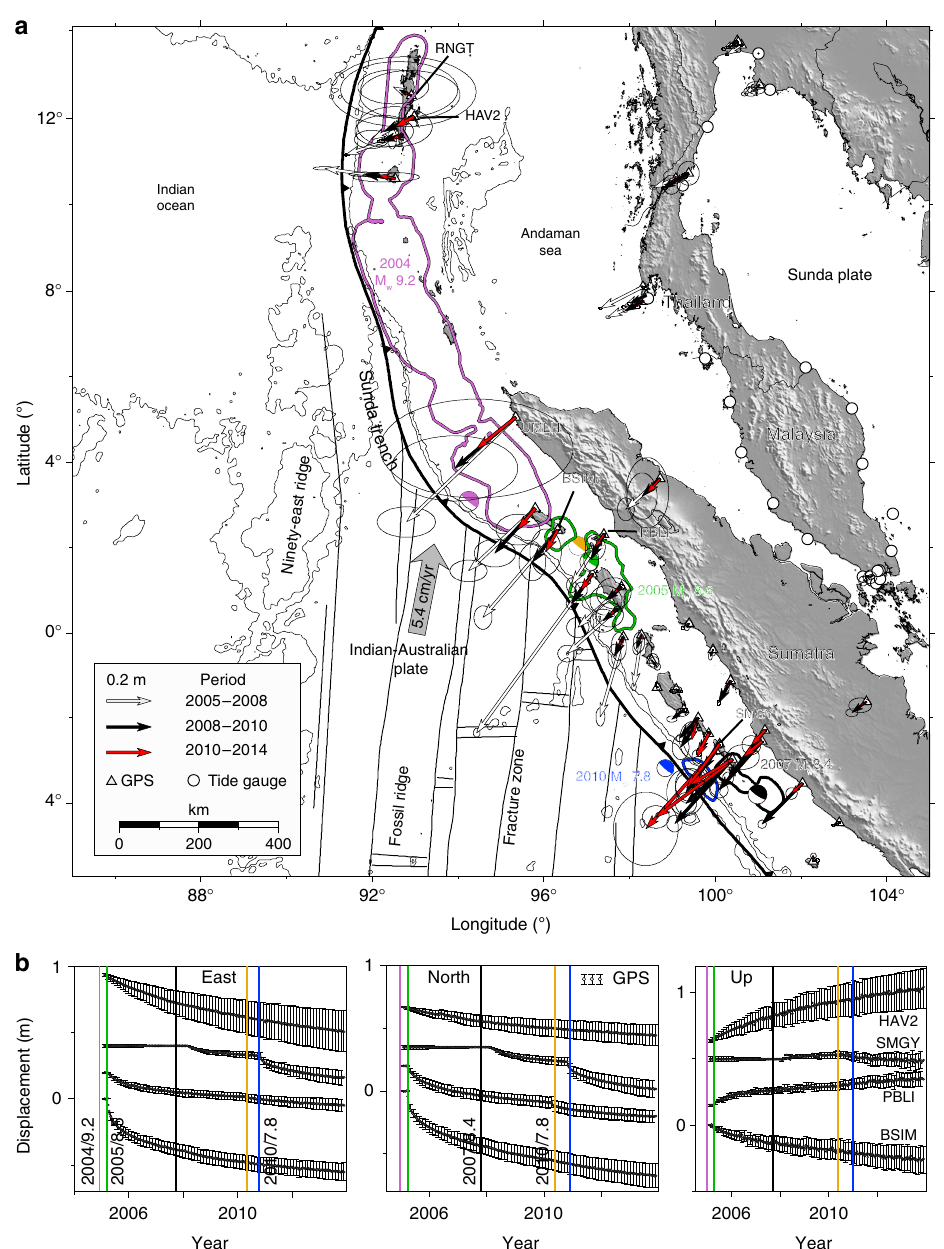
Fig. 1 Cumulative postseismic displacements following great earthquakes of the Sumatran subduction zone from 2005 to 2014 as recorded by regional GPS stations. a Cumulative postseismic displacements over three separate time periods with 1 σ error ellipses representing the 95% con fi dence intervals (note that for legibility we utilise the 60% con fi dence interval for sites UMLH and RNGT. Supplementary Fig. 4c illustrates the original 95% con fi dence intervals. All the GPS time series with the original “ relative uncertainties ” are shown in the Supplementary Fig. 4. Beach balls represent GCMT earthquake moment tensors of earthquakes, colour coded with event magnitude and times in b . Contours with matching colours to the moment tensors illustrate the 2m slip contour for the estimated coseismic rupture patches for the 2004 M w 9.2 Sumatra – Andaman 11 , the 2005 M w 8.6 Nias – Simeulue 23 , the 2007 M w 8.4 Bengkulu 24 and the 2010 M w 7.8 Mentawai earthquake 25 . b GPS data (are plotted every ~40 days for clarity) at some example stations, illustrating the complex deformation associated with multiple great megathrust events over the last decade. The coloured vertical bars indicate the year and magnitude of great of arbitrary three dimensional (3D) heterogeneities, while previous approaches were restricted to vertical strati fi cation and did not give afterslip a consistent treatment.